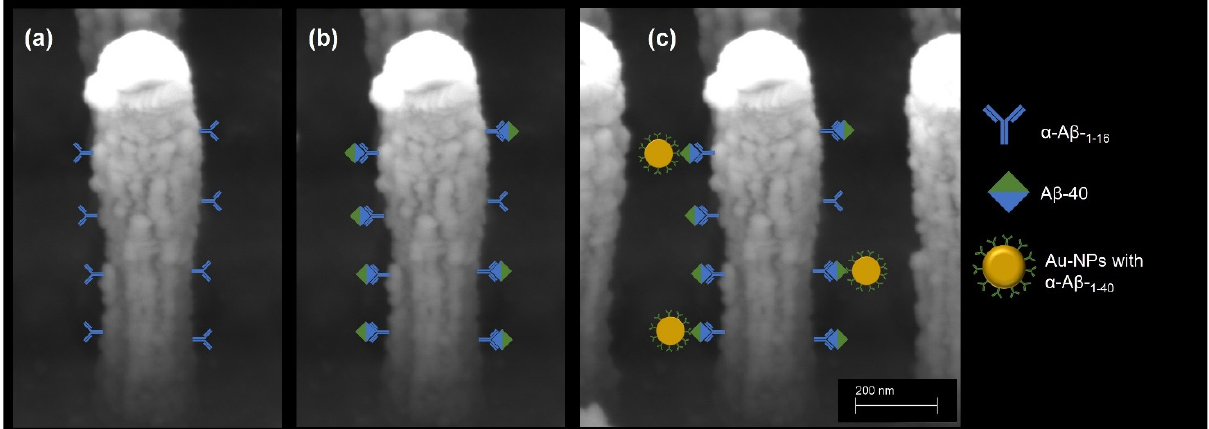
Figure 5. Schematic representation of ( a ) α -A β - 1-16 immobilization (capture antibody), ( b ) A β -40 binding with capture antibody and ( c ) α -A β - 1-40 recognition (detection antibody) enhanced with Au-NPs.